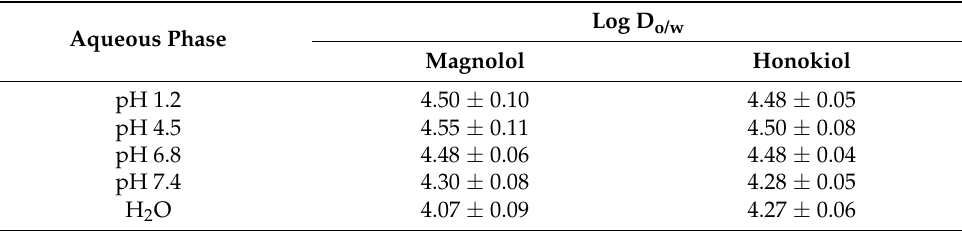
Figure 3. Solubility of magnolol ( ○ ) and honokiol (●) as a function of pH at 37 °C. pH 8p: phos- phate buffer; pH 8b: borate buffer.